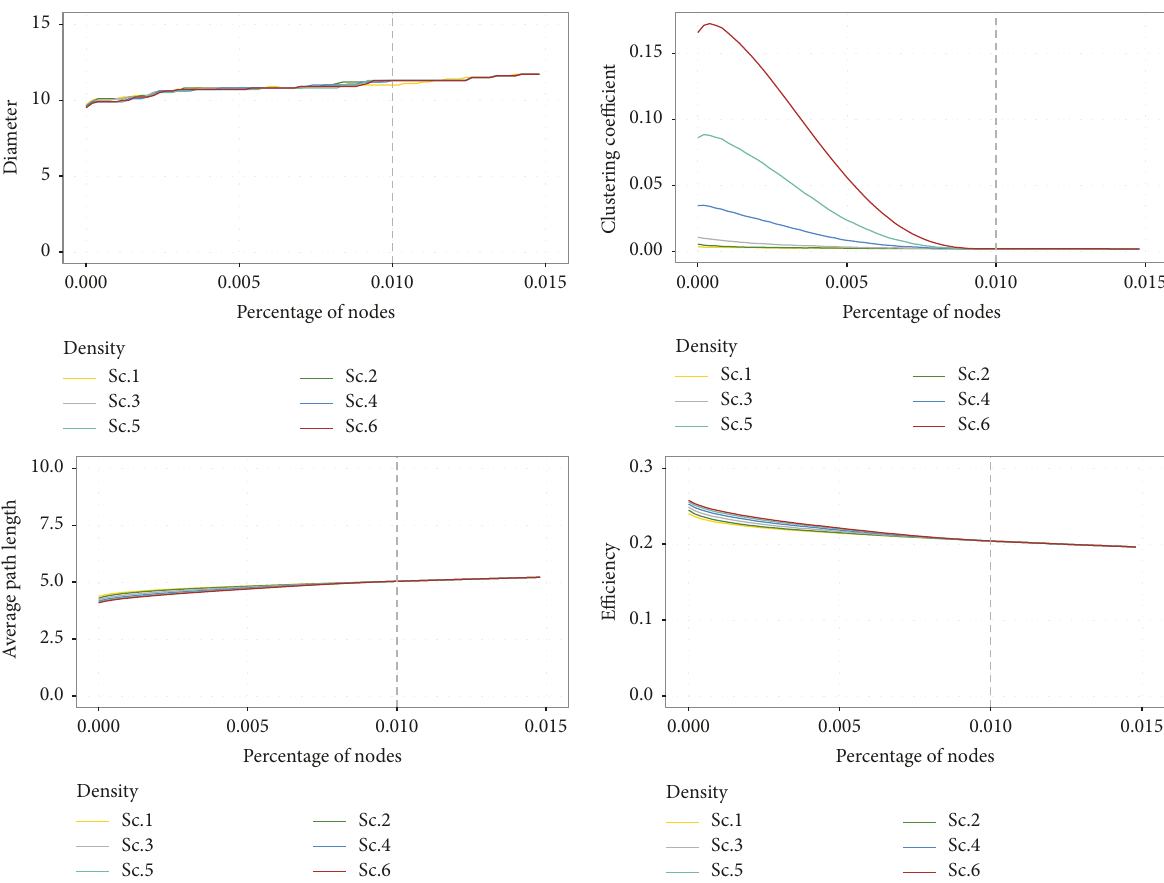
Figure 4: Resilience for simultaneous attack simulations with progressive manipulation of number of links in the network core; magnification of the area of Figure 3 in which the rich-club lays. The dashed line is placed in correspondence with the rich-club size. All results are averaged over 10